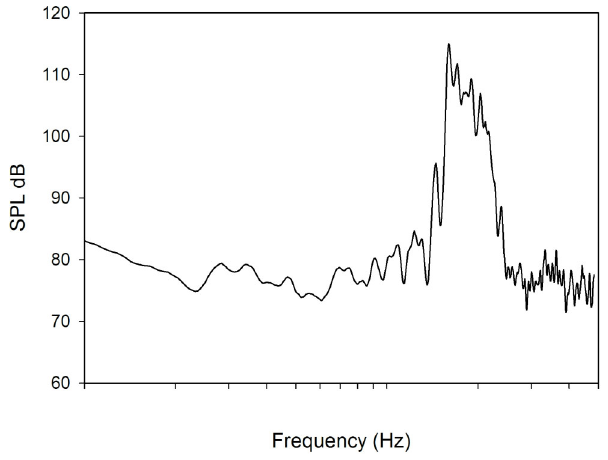
Figure 1. Energy distribution of the noise used in the